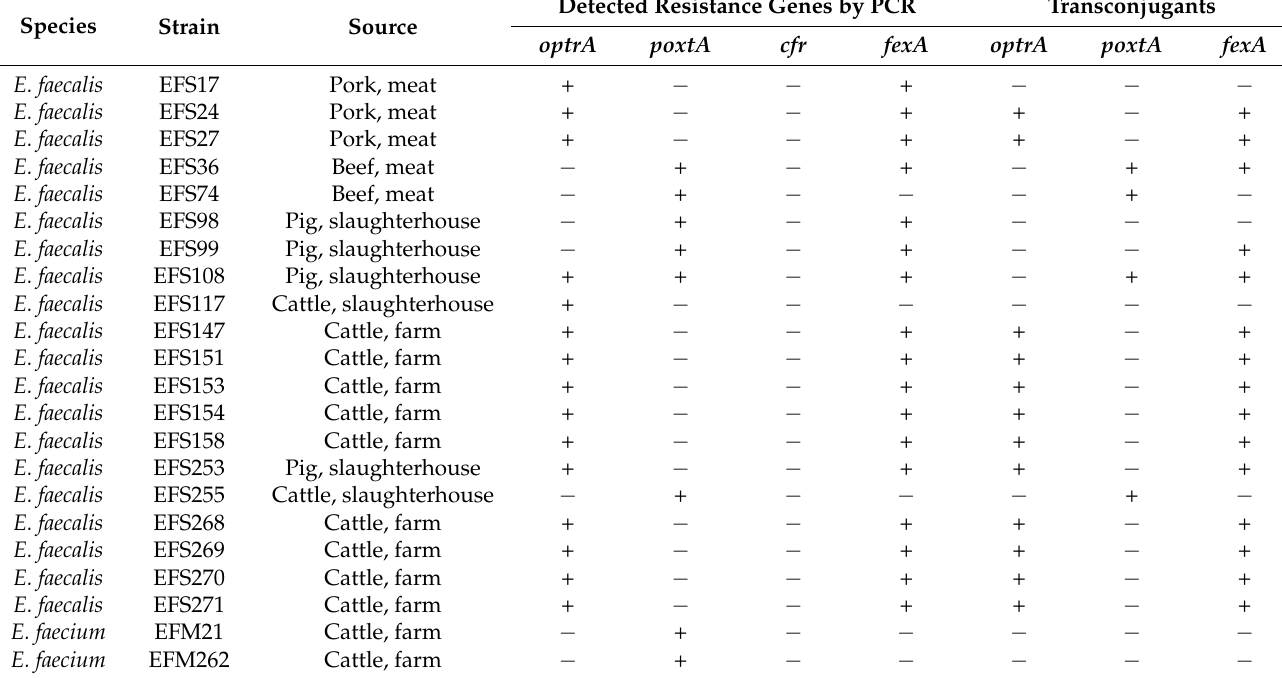
Table 1. Characteristics of enterococci strains harboring phenicol-oxazolidinone resistance genes.